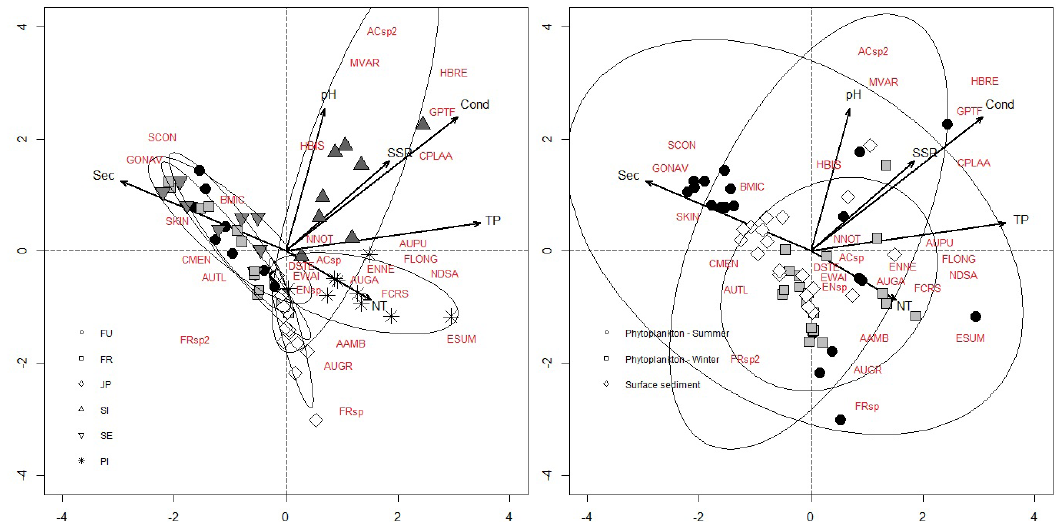
Figure 3. CCA ordination biplots of the Cachoeira da Fumaça (FU), Cachoeira do França (FR), Jurupará (JP), Salto do Iporanga (SI), Serraria (SE) and Paineiras (PI) reservoirs (A) and phytoplankton (summer and winter) and surface sediment. Confidence ellipses ( α = 0.95) shown. Coded according to Table